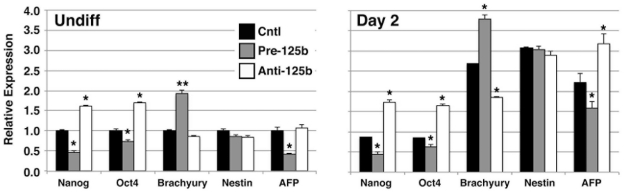
miR-125b inhibits the expression of pluripotency genes and promotes mesodermal development during hESC differentiation.hESCs were transfected with pre-miR-125b (pre-125b) or anti-miR-125b inhibitor (anti-125b), cultured in differentiation medium for 2 days, and analyzed for expression of pluripotency or early germ layer mRNAs by qPCR. Overexpression of pre-125b suppressed the expression of pluripotency markers, Nanog and Oct4, in undifferentiated hESCs and induced premature expression of the early mesodermal marker, Brachyury. Anti-125b promoted the expression of Nanog and Oct4 at day 2 of differentiation, and conversely inhibited the normal expression of Brachury at this time point. AFP, α-fetoprotein. Data shown are mean±s.e.m. (N = 3). *, p<0.05; **, p<0.01.